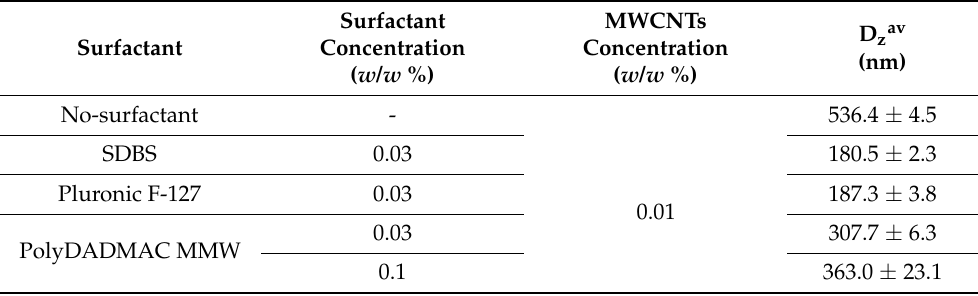
Table 2. Summary of Z-average diameter for MWCNTs dispersions with concentrations of 0.01% ( w / w ) applying different